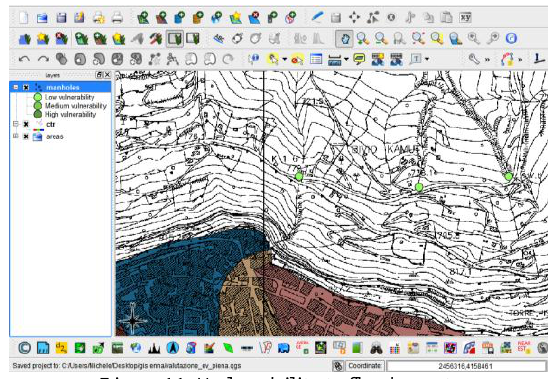
Figure 11. Vulnerability to flood events